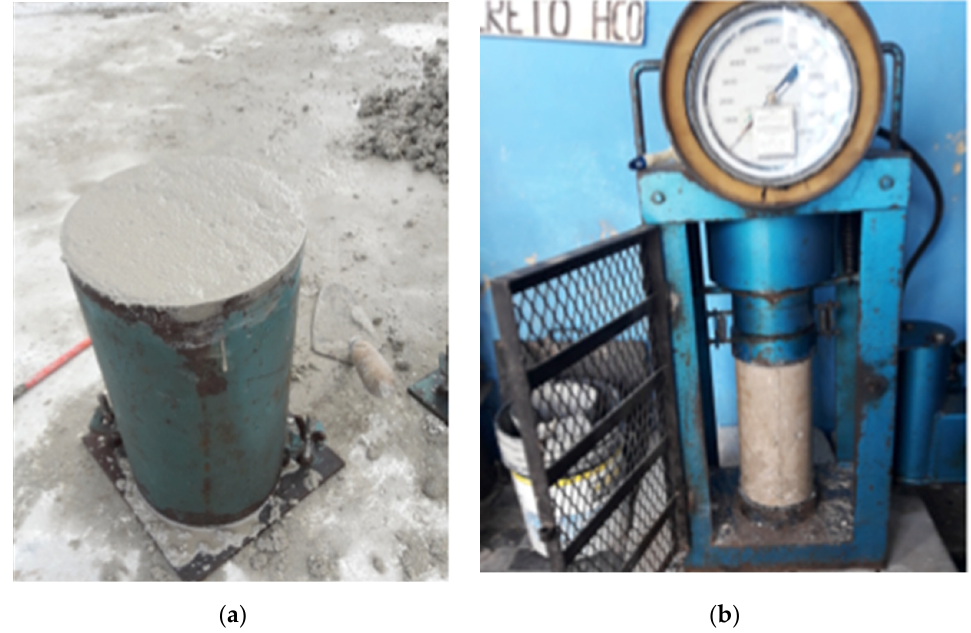
Figure 1. ( a ) Cylinder sample for compressive resistance and ( b ) compressive resistance assay.